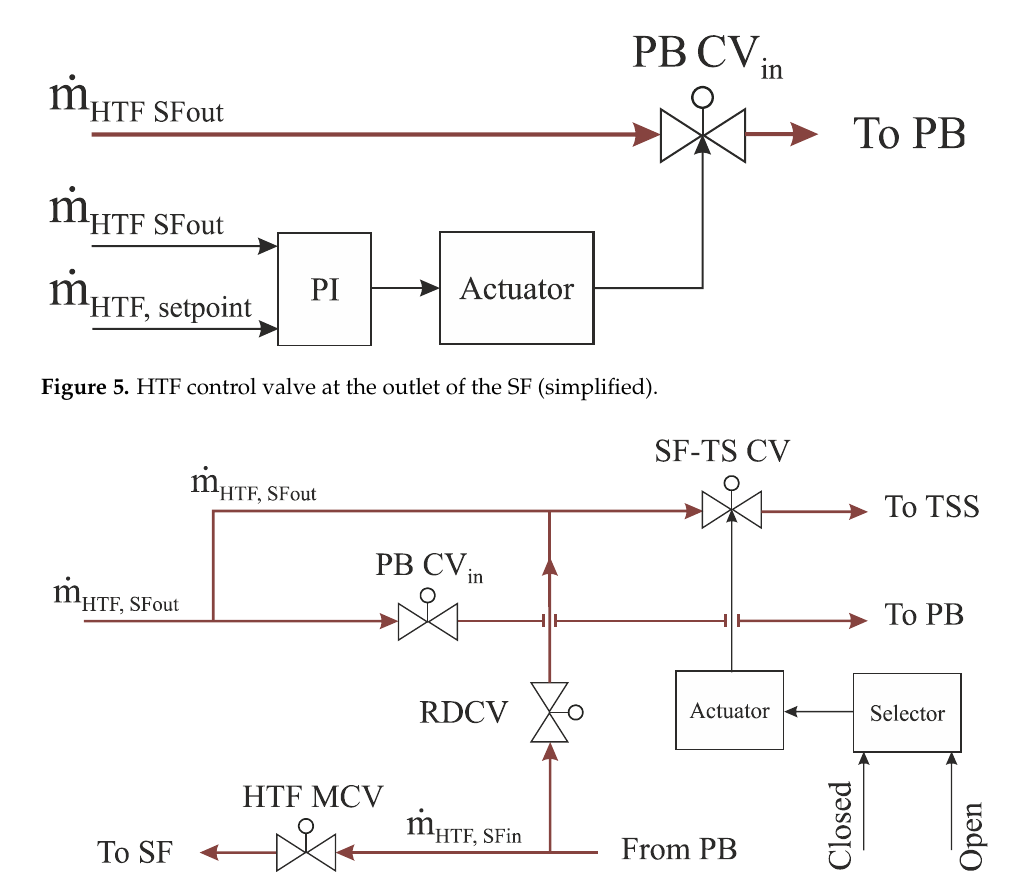
Figure 5. HTF control valve at the outlet of the SF (simplified).